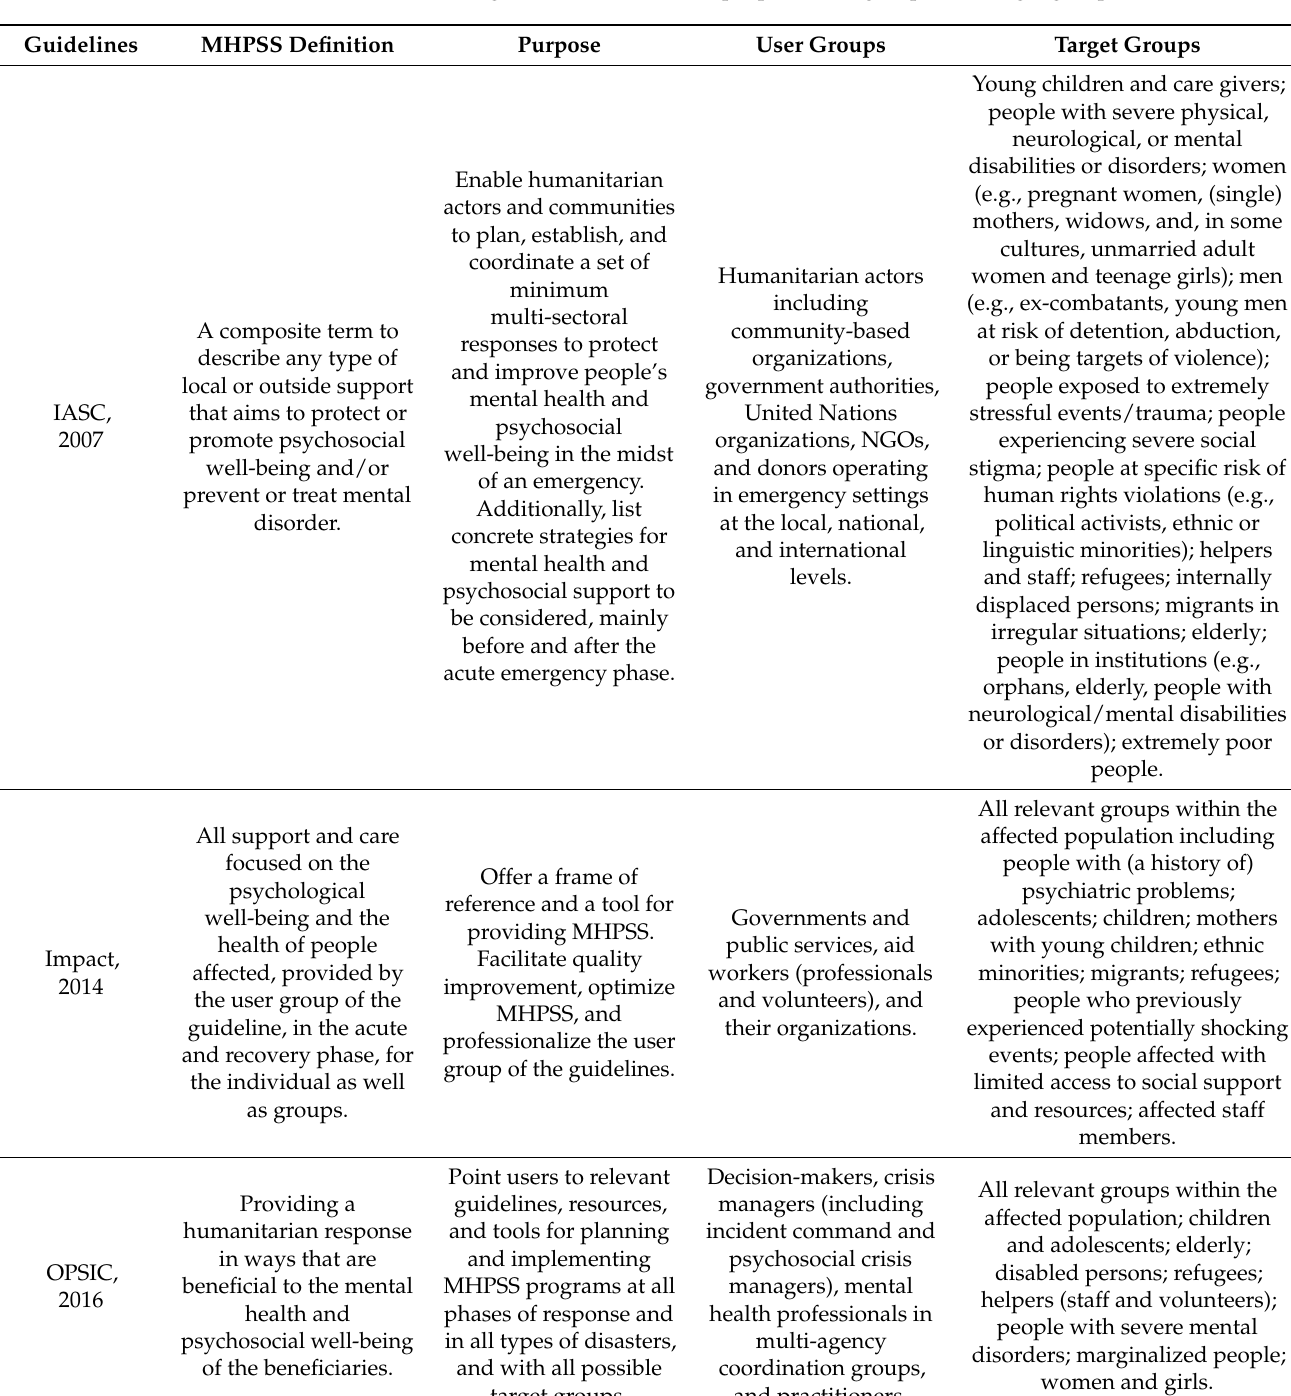
Table 1. MHPSS guidelines: definitions, purpose, user groups, and target